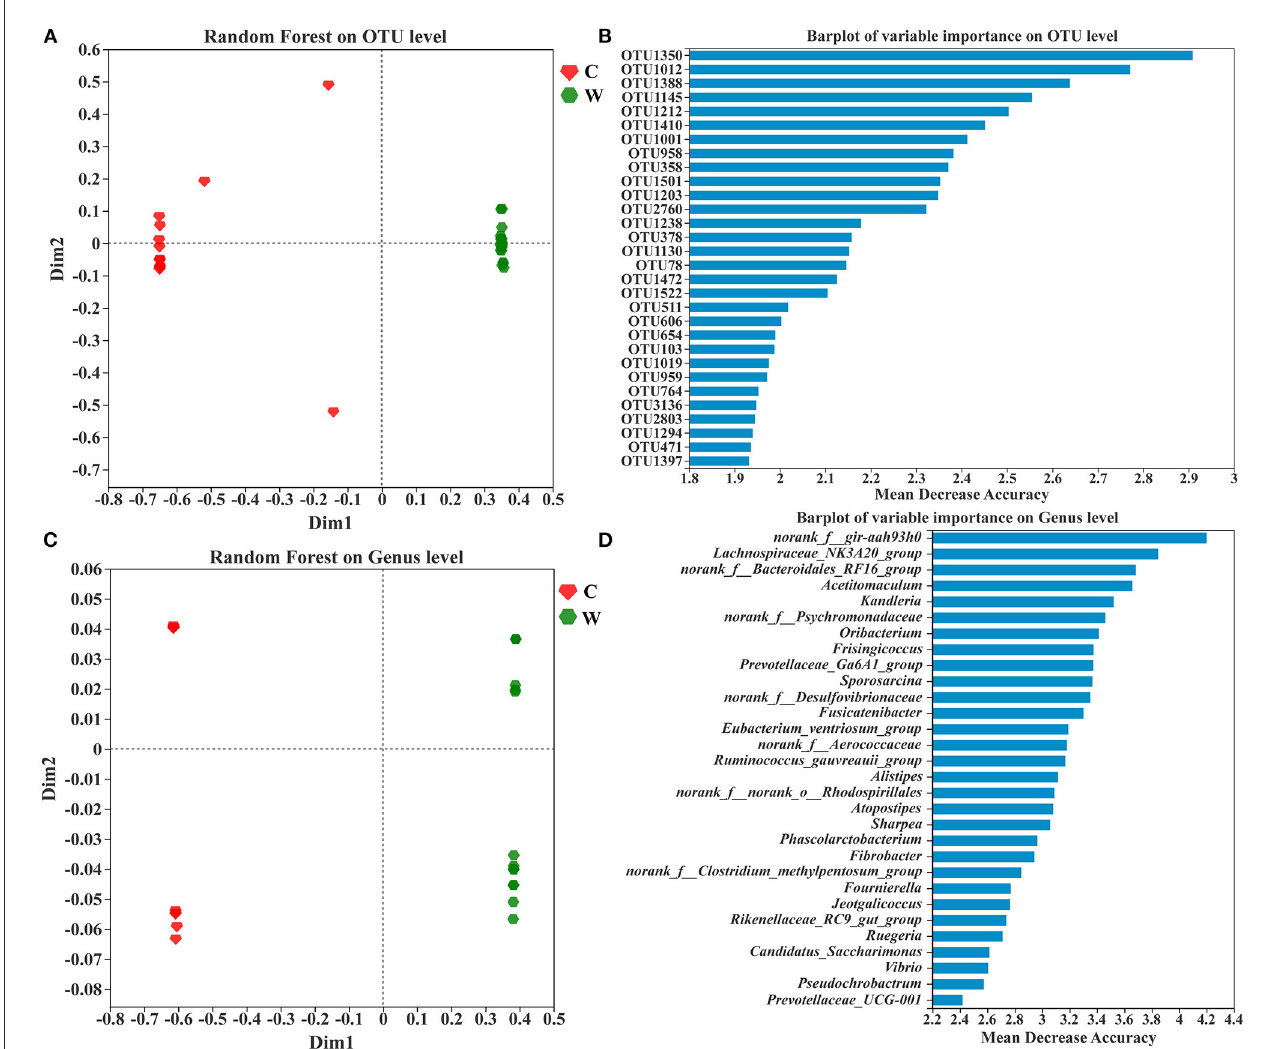
FIGURE4 Random forest analysis of sample clustering at OTU (A) and genus levels (C) , and the top 30 OTUs (B) and genus (D) with variable importance based on their mean decrease in accuracy.